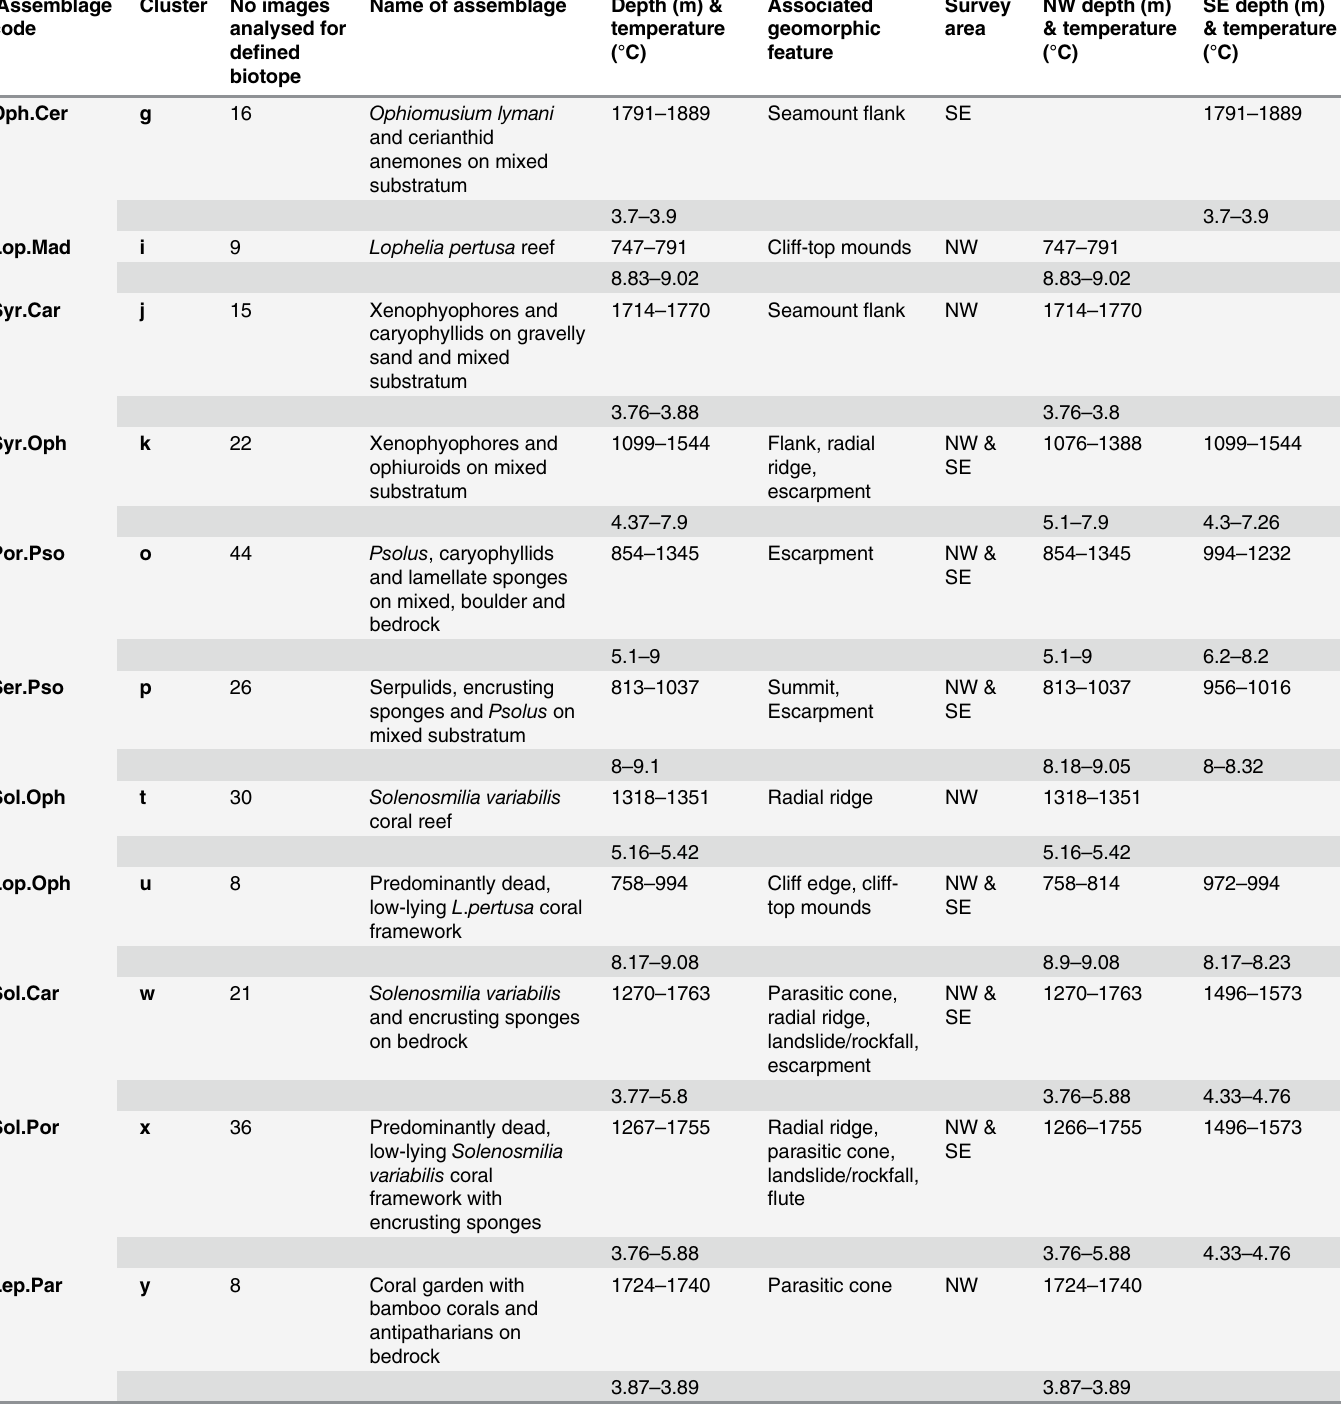
Table 2. Summary of biotope data mapped from the videos. Assemblage